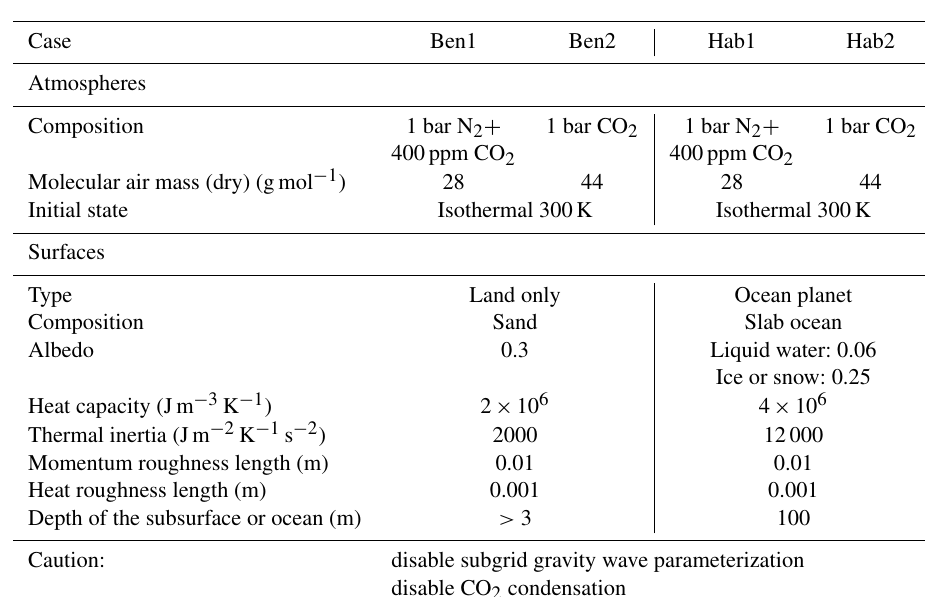
Figure 1. Surface contours for surface temperature, thermal emitted radiation (top of atmosphere, TOA) and reflected stellar radiation (TOA) for Hab1 simulated by the four GCMs: the UK Met Office United Model (UM), the Laboratoire Météorologie Dynamique Generic model (LMDG), the Resolving Orbital and Climate Keys of Earth and Extraterrestrial Environments with Dynamics (ROCKE-3D) and the National Center for Atmospheric Research Community Atmosphere Model version 4 modified for exoplanets (ExoCAM). Table 2. THAI experimental